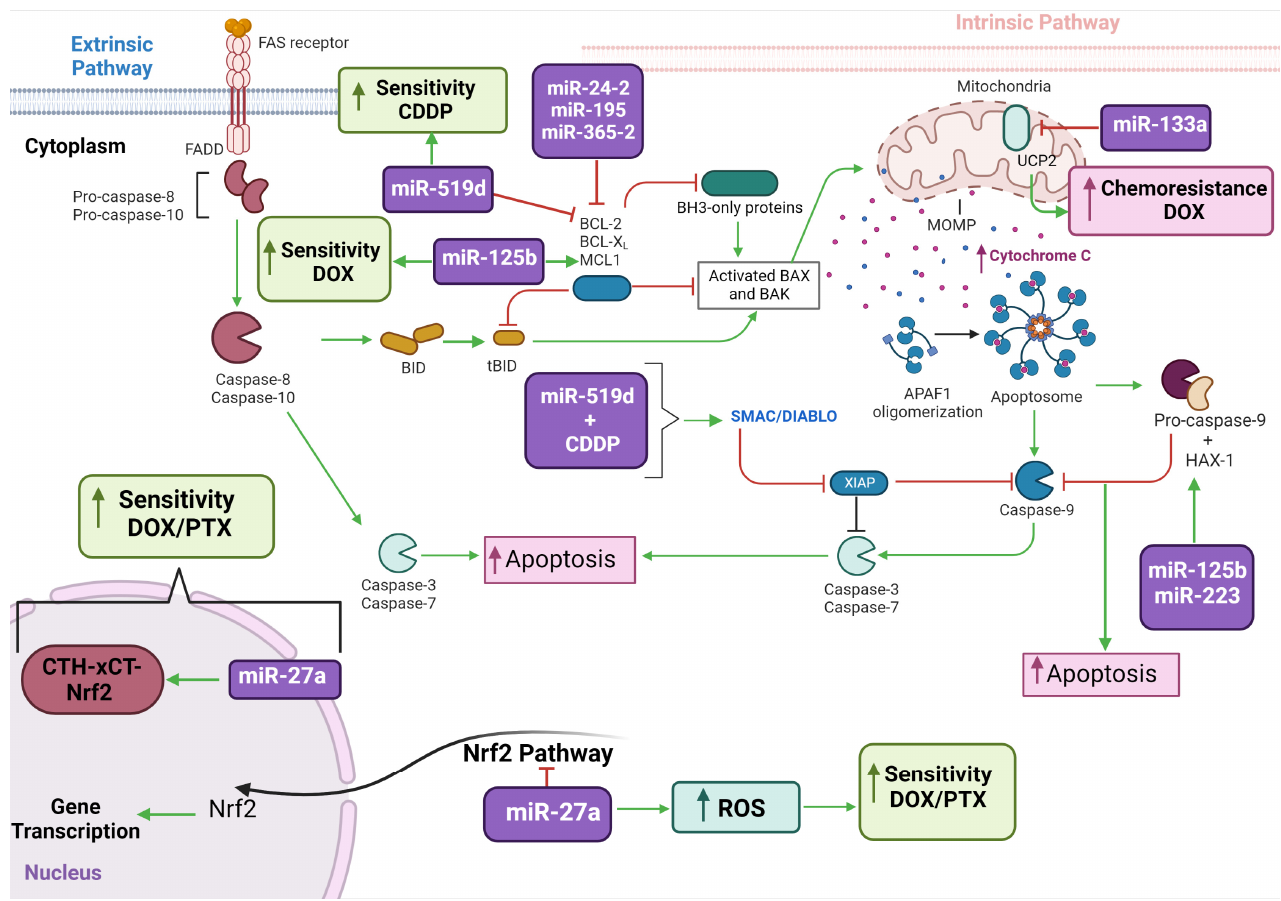
Figure 3. MiRNAs described in this systematic review with potential use as predictive molecular markers of treatment response and/or druggable targets. The figure illustrates the distinct mecha- nisms of the extrinsic and intrinsic pathways of apoptosis, by which the miRNAs mediate cytotoxicity to commonly-used cancer chemotherapeutic agents.